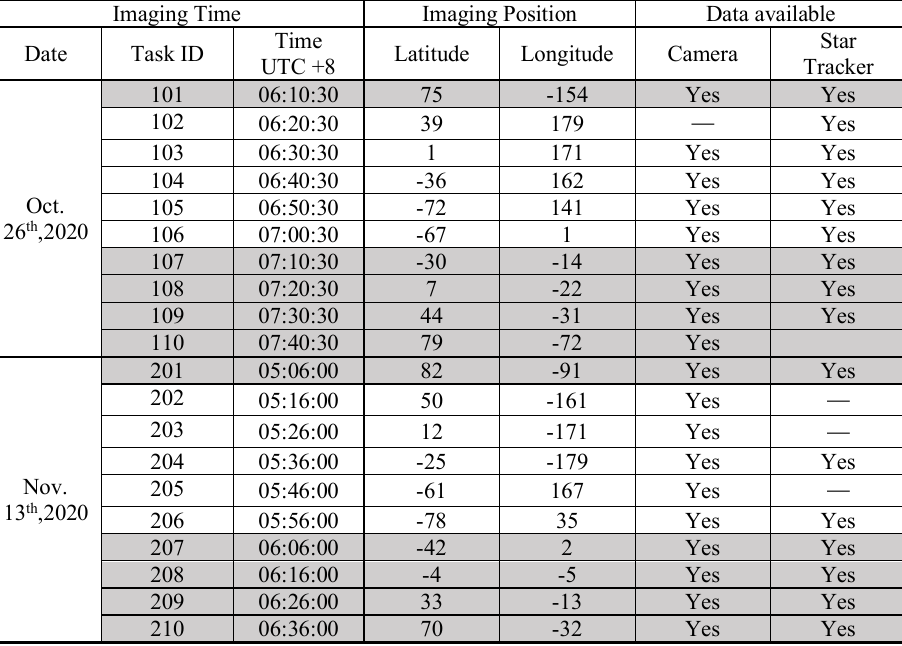
Table 2 . Imaging time and status of star observation of Jilin-1 video